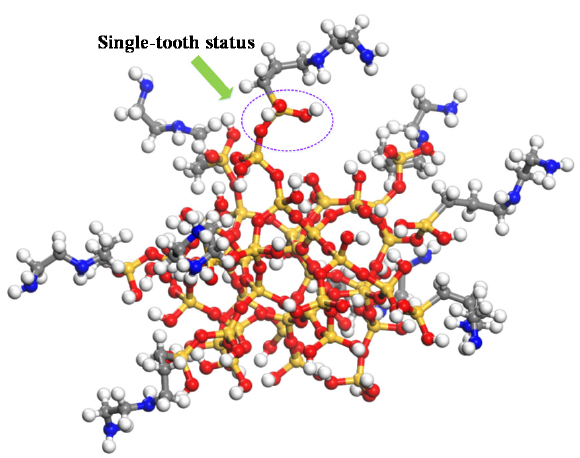
Figure 2. Schematic diagram of silane coupling agent grafted on the surface of nano silicon dioxide.